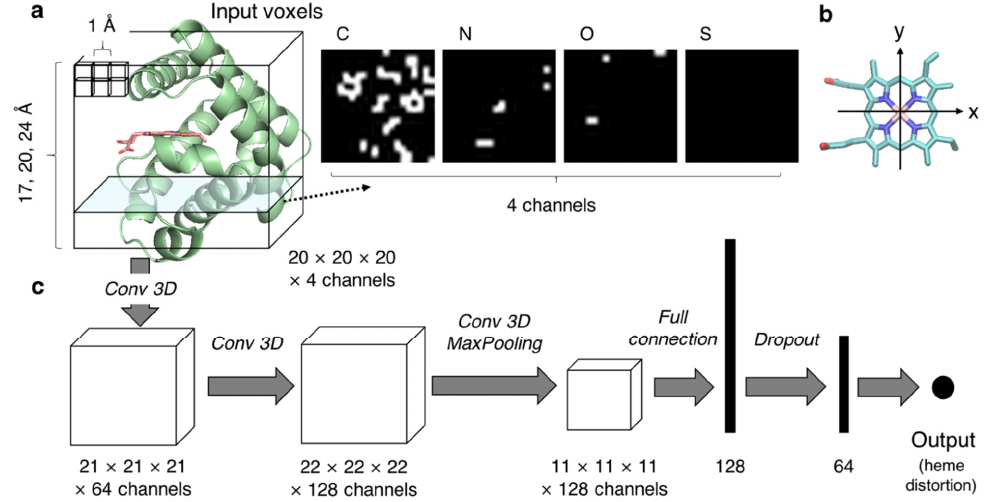
Figure 2. CNN model used in the present study. ( a ) A schematic diagram of input voxels. The protein backbone is represented as a green cartoon, and the heme molecule is shown as the licorice model colored in salmon. The input voxels were calculated for each atom (C, N, O, or S), as illustrated in the right panel. The heme molecule(s) were excluded in the voxel calculation. ( b ) A diagram of determination of x- and y-axes based on the coordinates of heme for the calculation of input voxels. The heme molecule is represented as the licorice model, and the atoms used for the determination of the axes are shown by dotted circles. ( c ) Layers included in the developed CNN model are shown. Table 1. The layers and parameters of the CNN model used in this study. Output Dimension Layer Function Filter (Kernel)